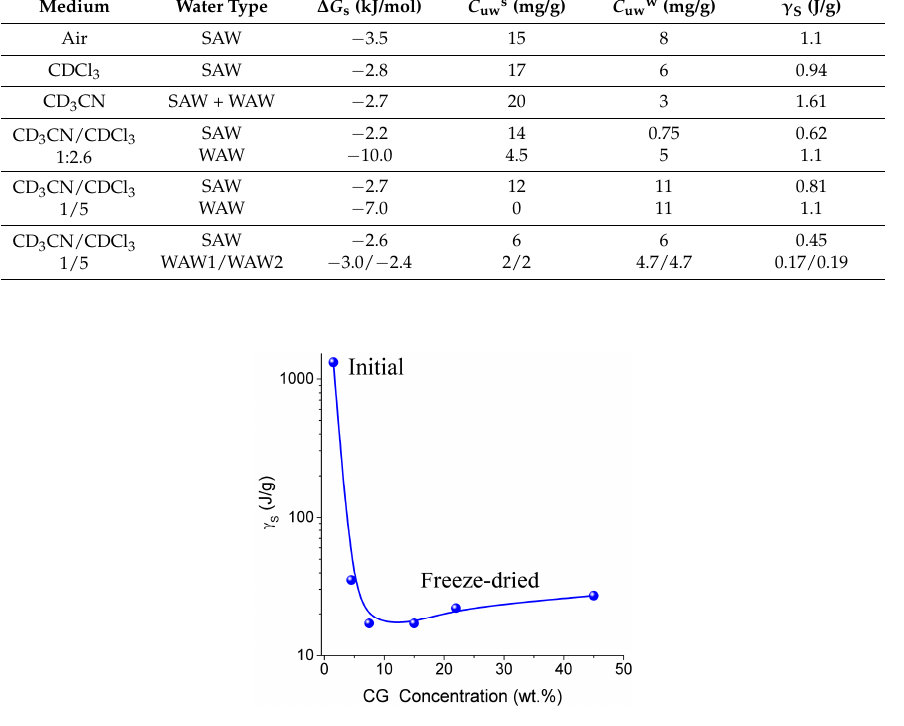
Figure 10. The free surface energy as a function of the collagen concentration in the CG hydrogel (adapted from [76] with permission, Copyright 2006, Elsevier). (adapted from [76] with permission, Copyright 2006,